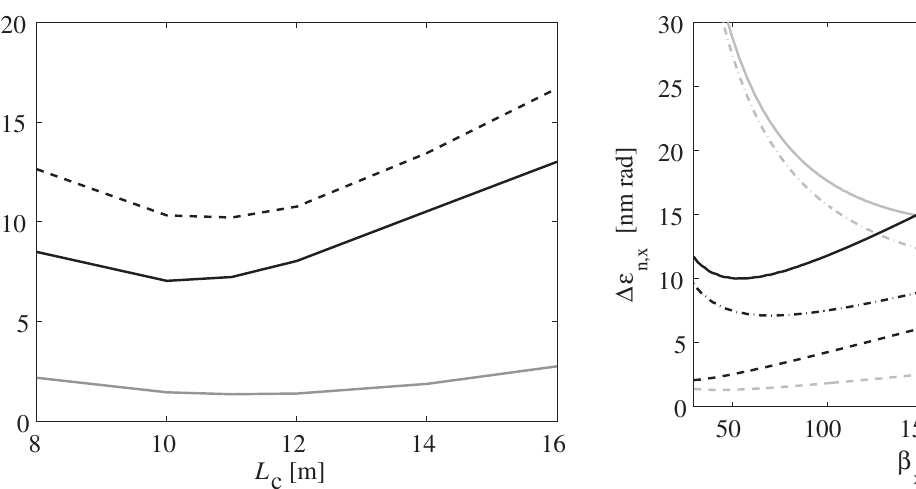
FIG. 12. ISR (dashed), CSR (dash-dotted), and ISR (cid:5) CSR (solid) emittance growth in the optimized C-chicane (gray) and S-chicane (black) vs initial beta function. Only the values obtained for the optimum alpha are shown.